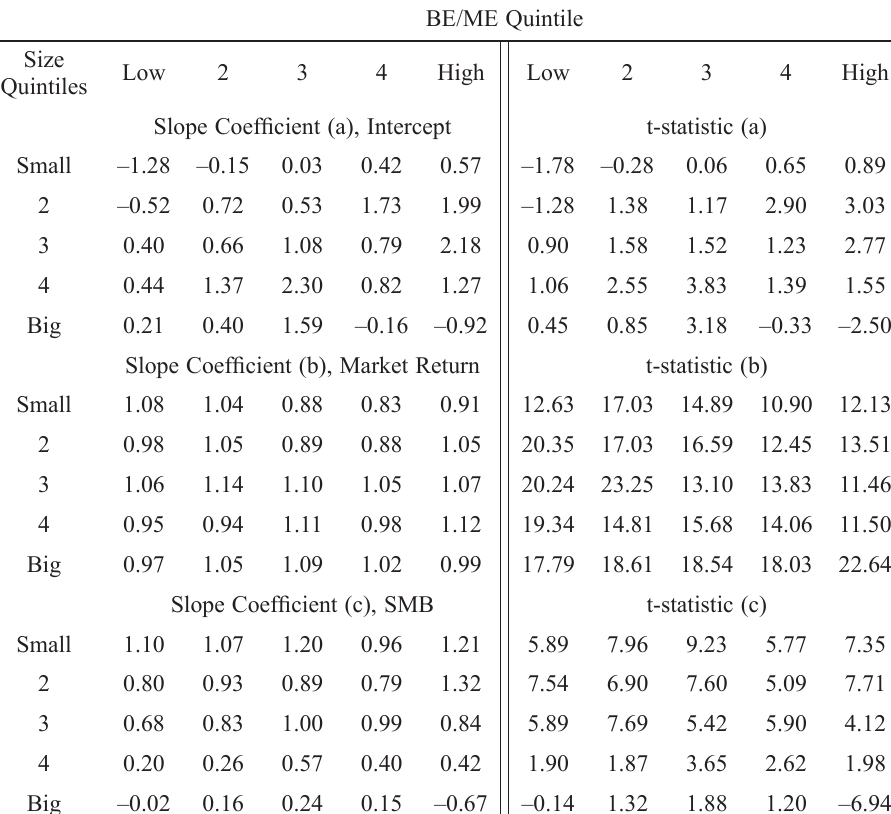
Table 7. Four-factor model: regression of excess stock returns on the excess